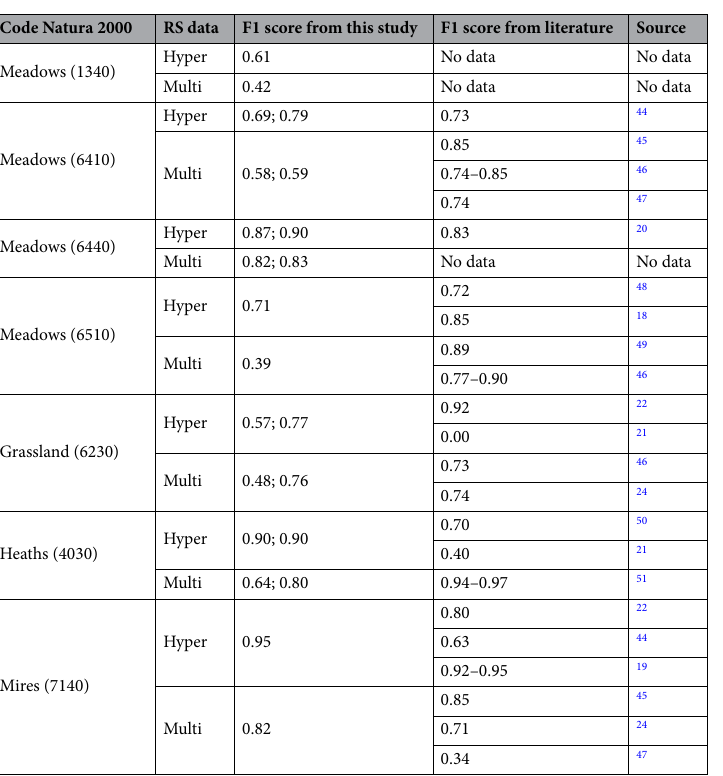
Table 4. The overview of the accuracies for individual Natura 2000 habitats acquired in this study and from the literature review. The table includes only the results of studies using hyperspectral data (Hyper) or multispectral data (Multi) and the sources of accuracies for classes of Natura 2000